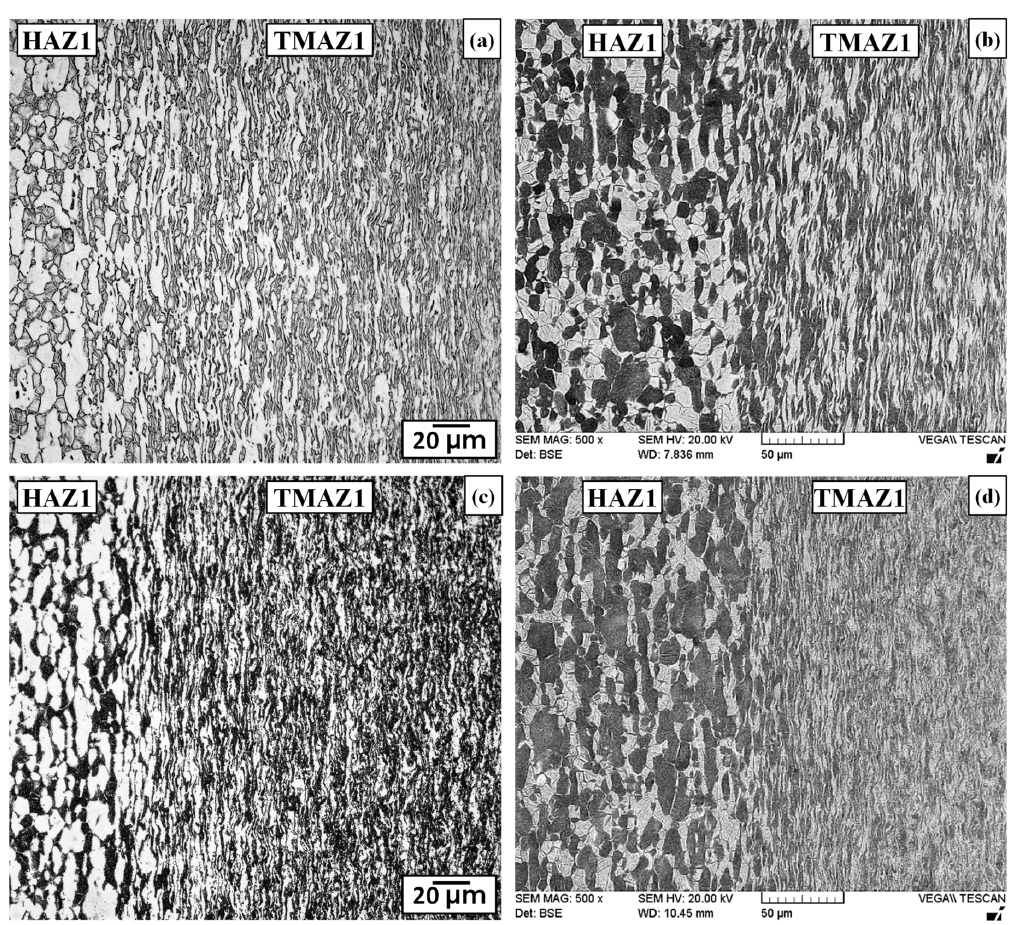
Figure 8. Microstructures in thermomechanically affected zone (TMAZ)1 between the CWZ and heat affected zone (HAZ)1 next to the Ti-6242 PM ( a , b ) AWed (OM and SEM) ( c , d ) SRAed (OM and SEM).